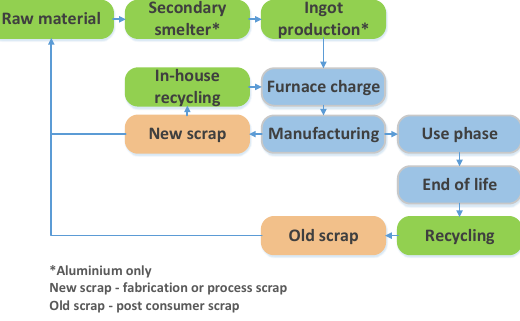
Figure 18. Material flow diagram of the recycling.